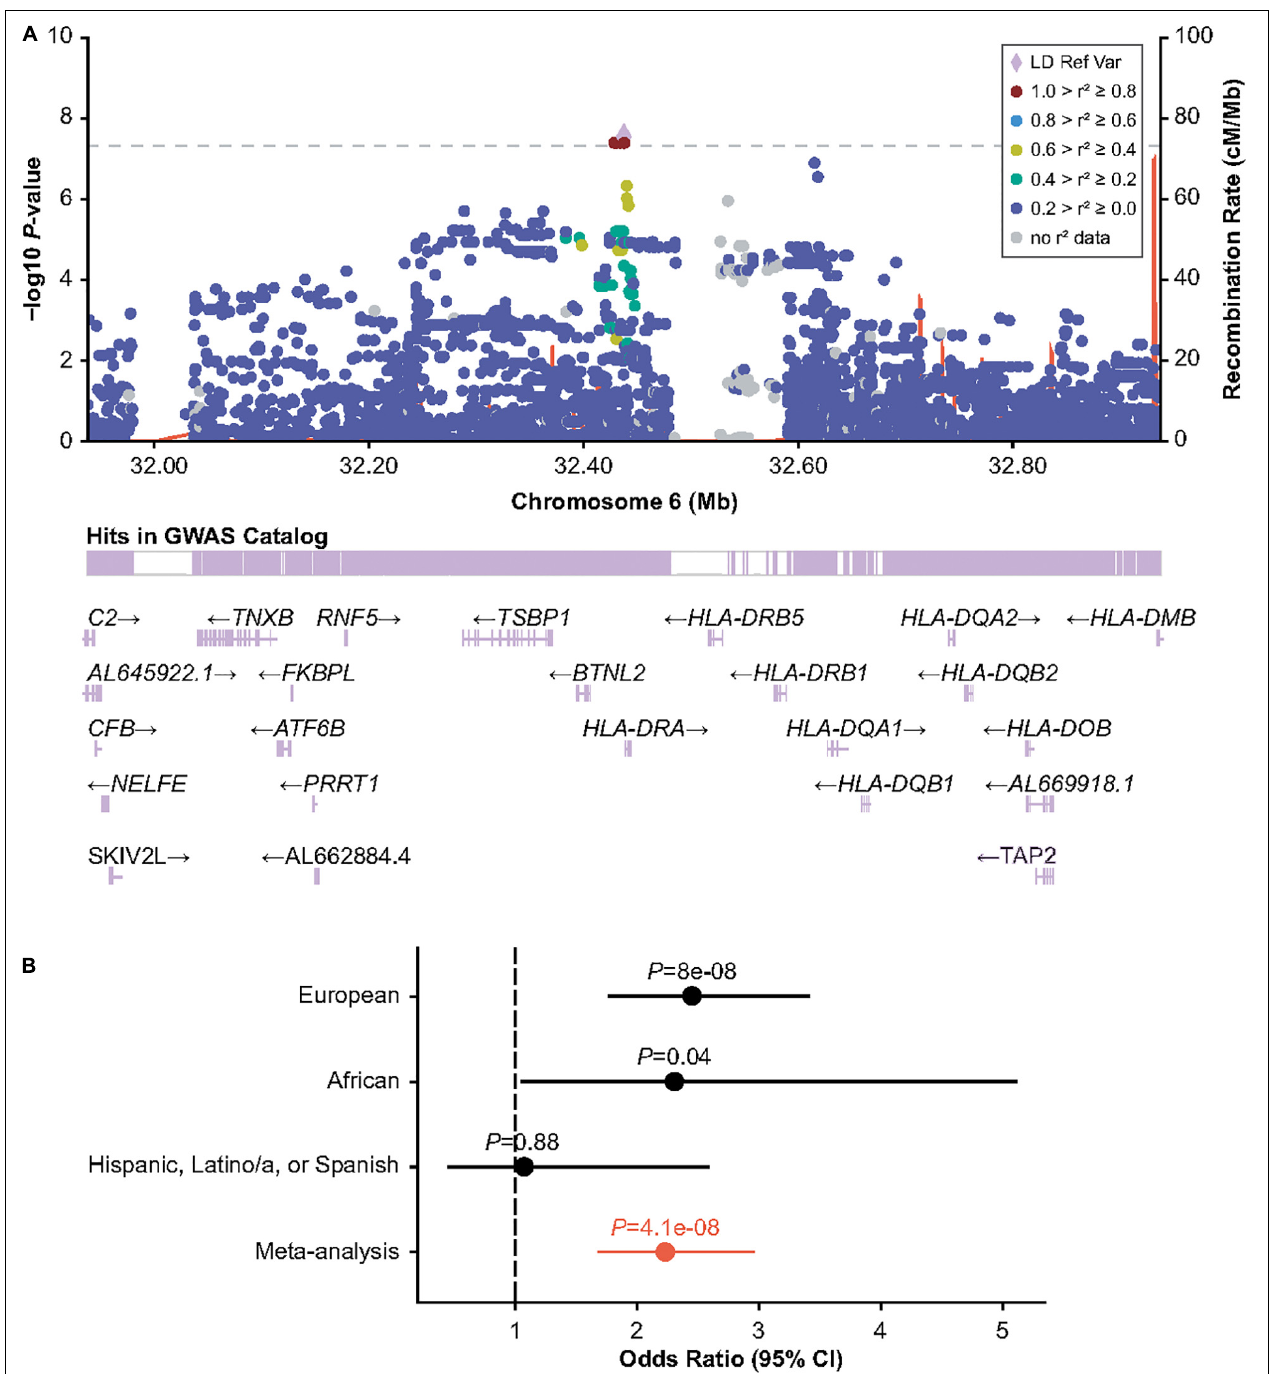
FIGURE 2 | Association of human leukocyte antigen (HLA) region variant 6:32438468_CA/C with inhibitors in participants with HA with intronic F8 inversions. (A) LocusZoom plot showing GMMAT score test P-value within the HLA region. (B) Wald-test P-value and odds ratios for the discovery (European ancestry) analysis, and replication analyses in individuals of Black or African American and Hispanic, Latino/a, or Spanish origin. Odds ratios are calculated for the CA allele. Meta-analysis odds ratio and P values were calculated by inverse variance meta-analysis. CI, confidence interval; GMMAT, generalized linear mixed-model association tests; GWAS, genome-wide association study; LD Ref Var, linkage disequilibrium reference variant; HA, hemophilia A.